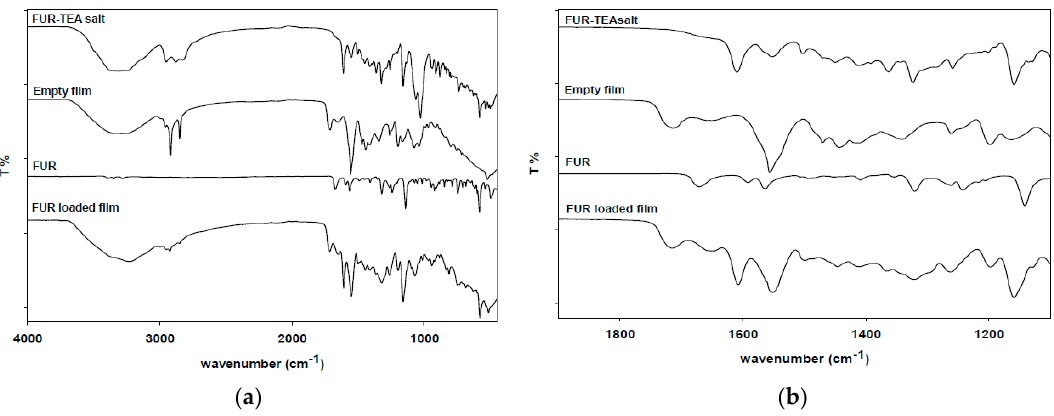
Figure 2. ( a ) Attenuated Total Reflectance-Fourier Transform Infrared Spectrometer (ATR-FTIR) full spectra of FUR-loaded film, empty film, FUR, and FUR-Triethanolamine (FUR-TEA) salt. ( b ) Magnification of the 2000–1000 cm − 1 portion of the spectra.